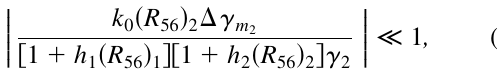
prior to BC2 m 2 0